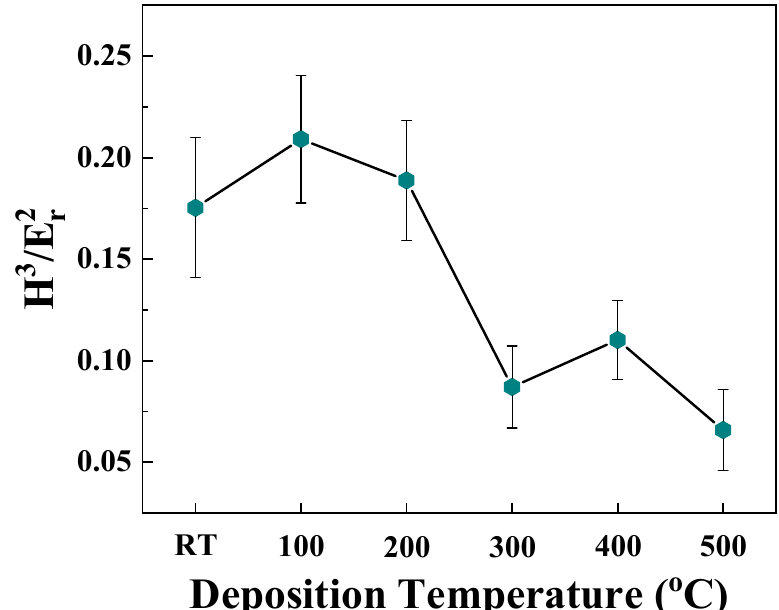
Figure 10. The variation of H 3 /E 2 ratio, which is called the plasticity index, for Mo films deposited at various temperatures. Note that lower values of average crystallite size and finer microstructure in a temperature range under 300 °C indicates a region of superior coating elastic properties and wear resistance.